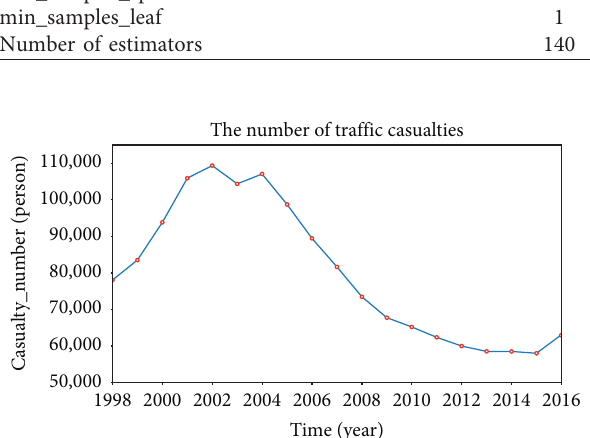
Figure 4: Trend chart of actual traffic accident deaths in China from 1998 to 2016.